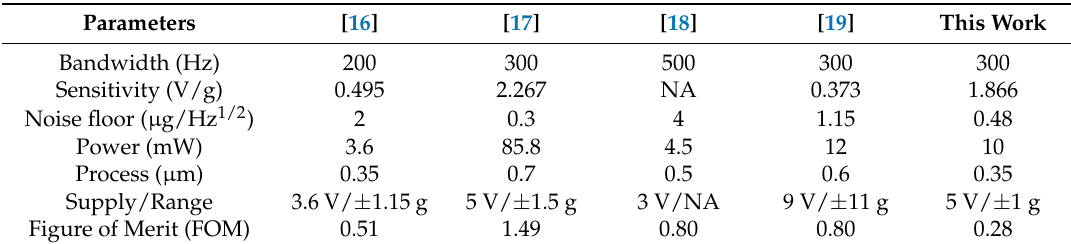
Table 4. Comparison of this work with other